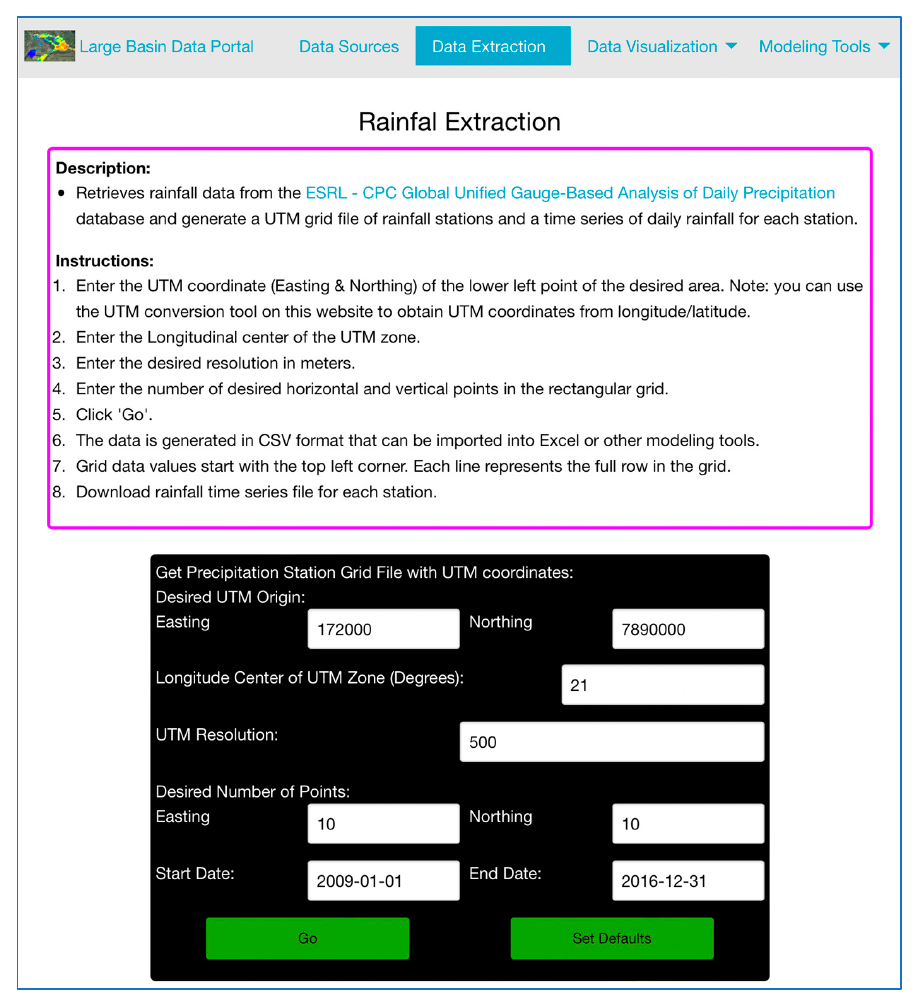
Figure 4. Screenshot of the Large Basin Data Portal rainfall extraction tool with description, usage instructions, and input parameters.